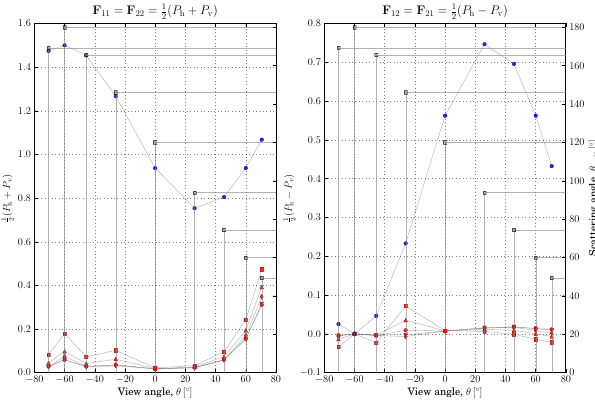
Figure 9. Elements F 11 (left panel) and F 21 (right panel) of the scattering matrix F (θ scatt ) for Rayleigh scattering (blue circles) as well as due to different cloud droplet sizes shown in red using differ- ent marker shapes (a square for r 0 = 5µm, a triangle pointing up for r 0 = 7 . 5µm, a circle for r 0 = 10µm, a triangle pointing down for r 0 = 12 . 5µm and a diamond for r 0 = 15µm). Given a solar zenith angle, θ 0 = 60 ◦ , the scattering angle θ scatt is shown on the right ordinate of each panel (grey squares) as a function of view angle within the principal plane.